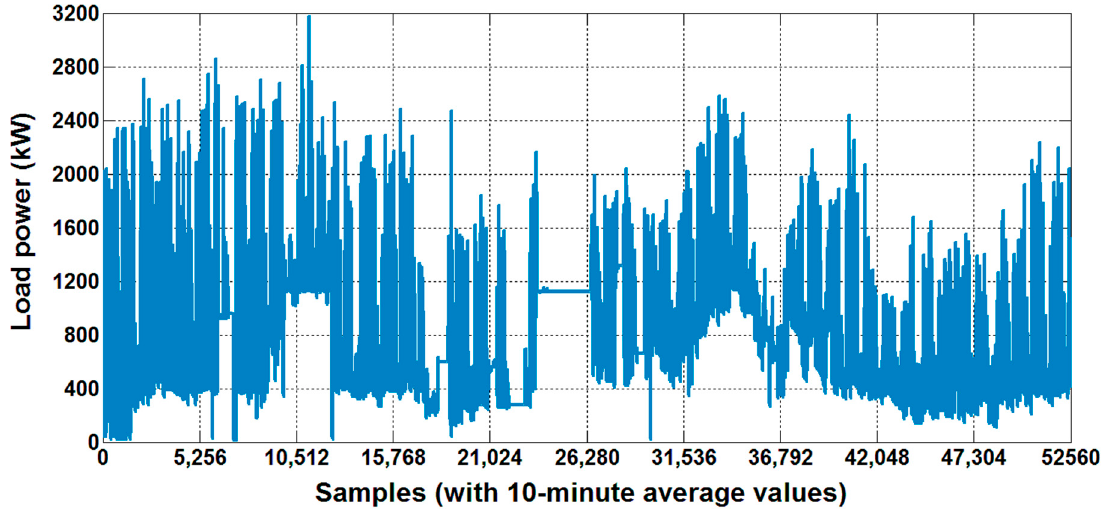
Figure 2. A one-year (1 May 2014–30 April 2015) load demand curve.